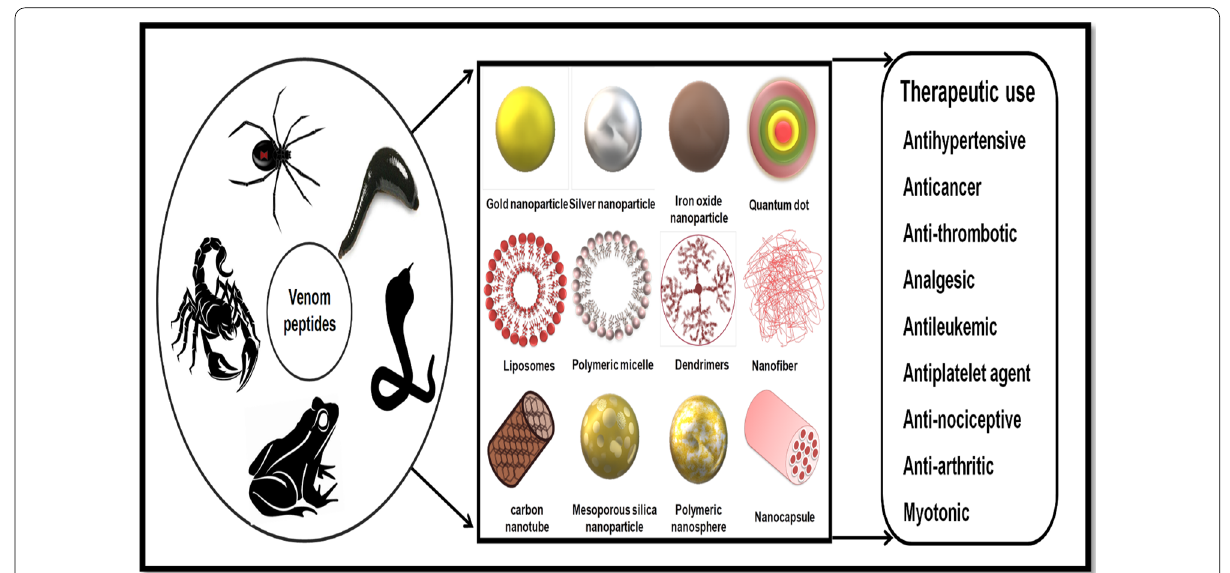
Fig. 4 Venom peptides formulated by using nanoparticles for different therapeutic